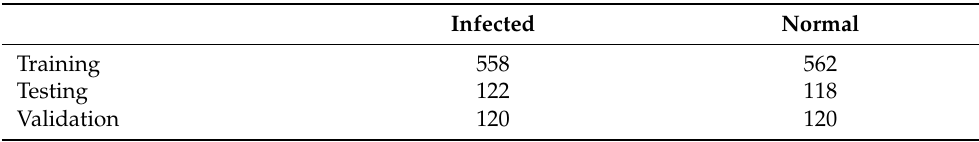
Table 1. Sample number of Train, test and validation sets.